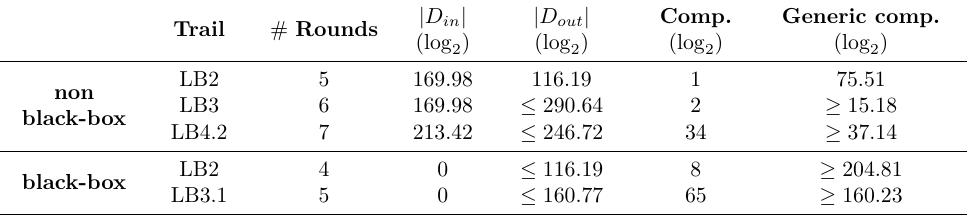
Table 4: Parameters of the improved limited-birthday distinguishers on the Ascon permutation (320